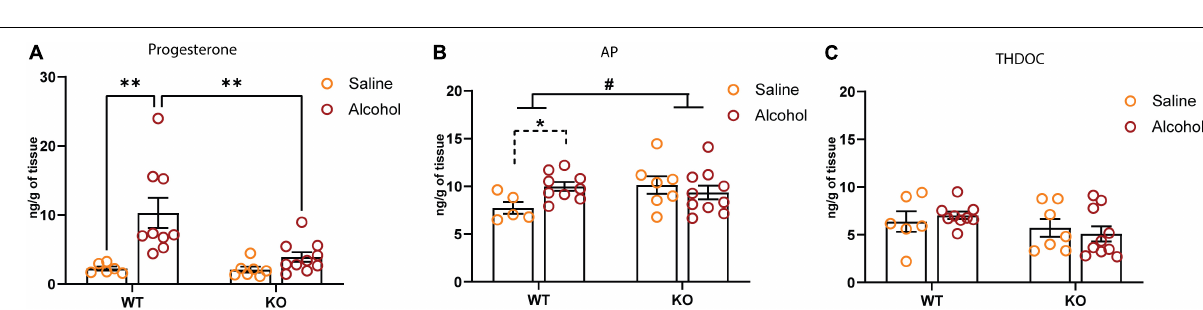
FIGURE 5 | Effect of voluntary alcohol consumption on GABA A receptor gene expression. (A) Delta subunit mRNA level in the hippocampus of GABA B ( 1 ) WT, KO, and HZ and mice at the end of the last drinking session of 2BC. (B) Bar graphs represent the analysis of alpha4 subunit mRNA level in the hippocampus of GABA B ( 1 ) WT, KO, and HZ mice at the end of the last drinking session of 2BC. All data are expressed as mean ± SEM; ( n = 10/group). Post hoc test ( ∗ p < 0.05; ∗∗ p < 0.01; ∗∗∗∗ p < 0.0001).